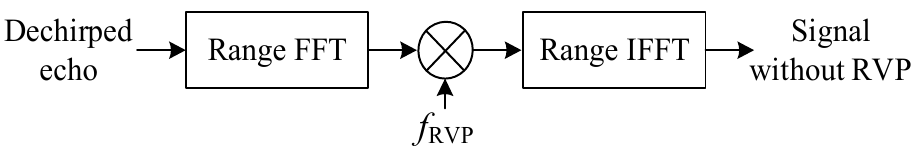
Figure 3. Flowchart of the RVP removal manipulation.